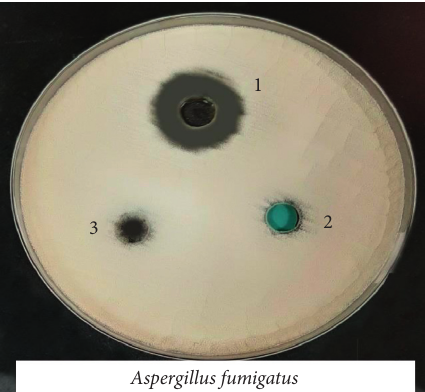
Figure 14: Microbiological screening of Ni(II), Cu(II) and Mn(II) complexes with S. aureus.